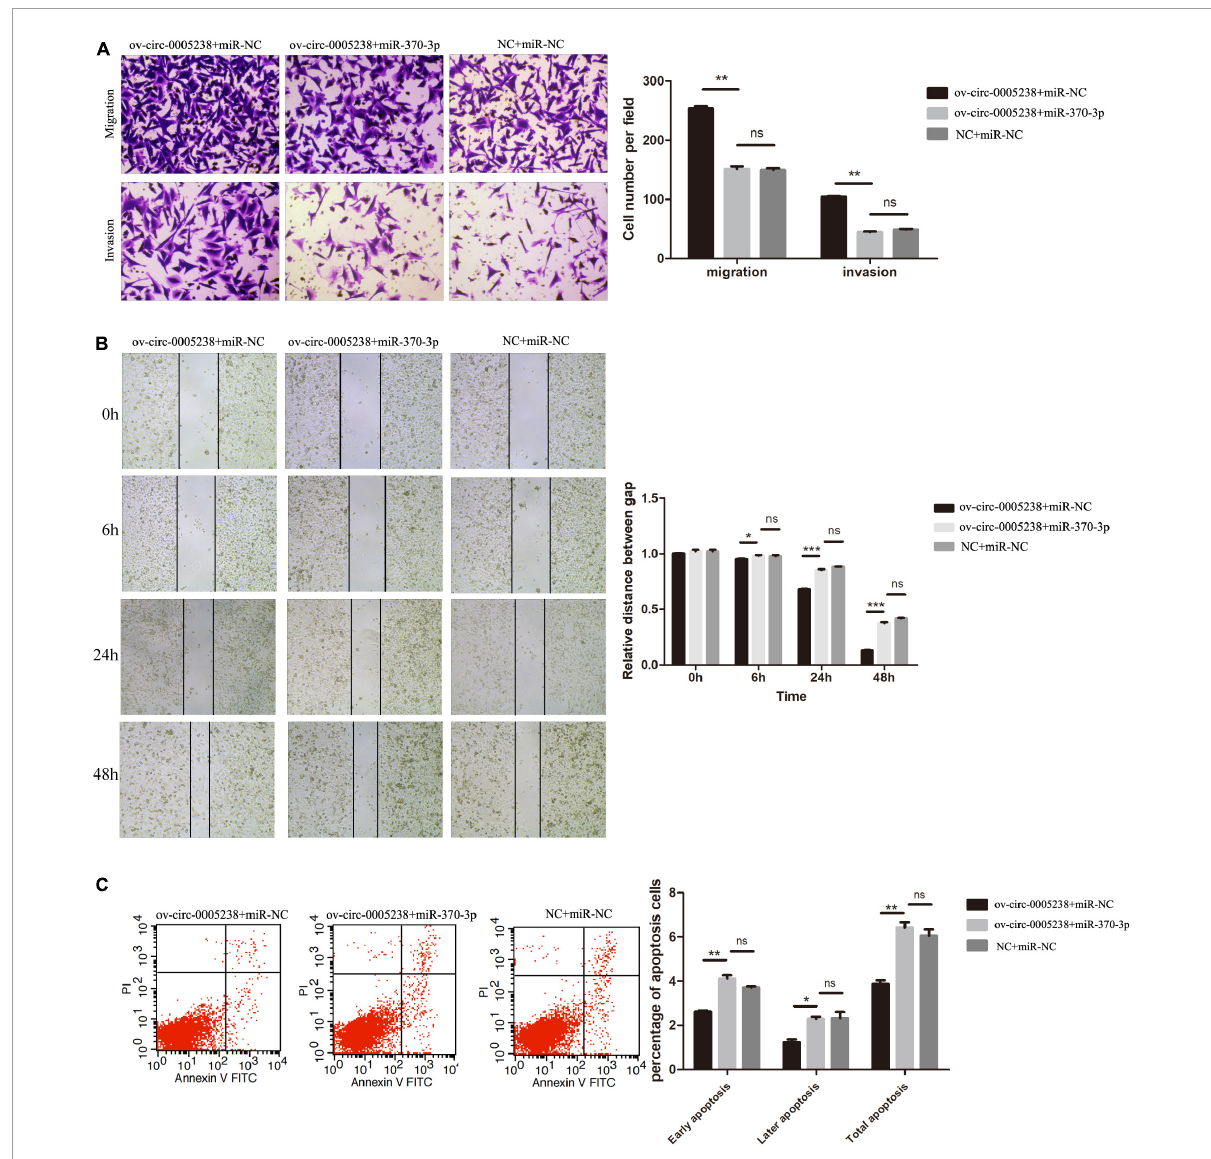
FIGURE7 Hsa-miR-370-3p overexpression eliminated the effect of hsa-circ-0005238 overexpression in HTR-8 cells. (A) Representative images and quantification of migration and invasion. (B) Representative images of wound healing assay and the relative distance between gap. (C) Representative images and quantification of apoptosis. * P < 0.05, ** P < 0.01, *** P <